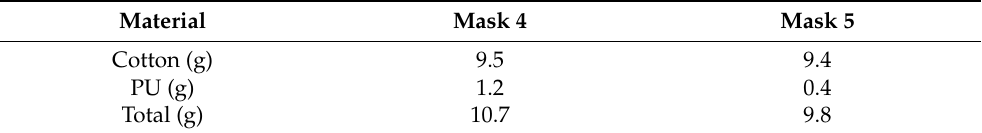
Table 3. Weights of masks in